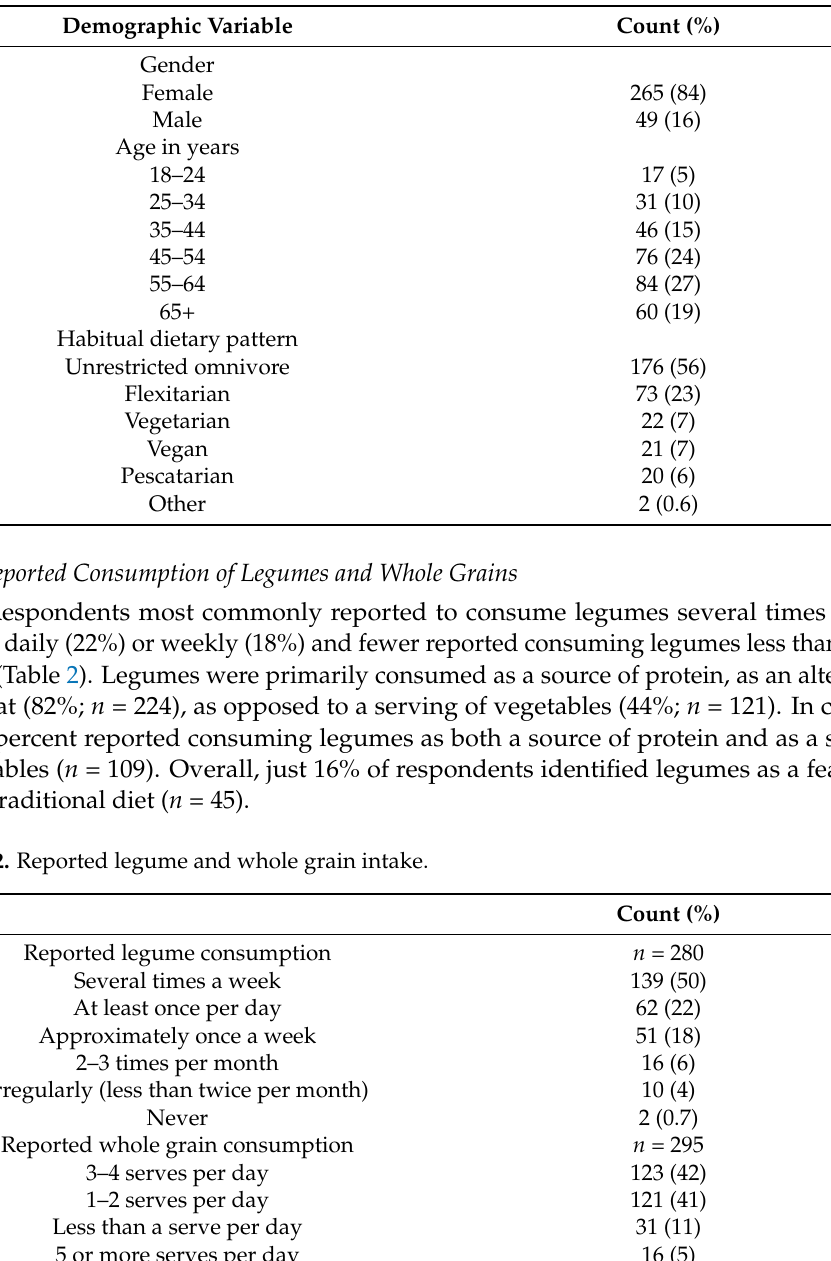
Table 1. Demographic characteristics and dietary pattern of respondents ( n = 314).